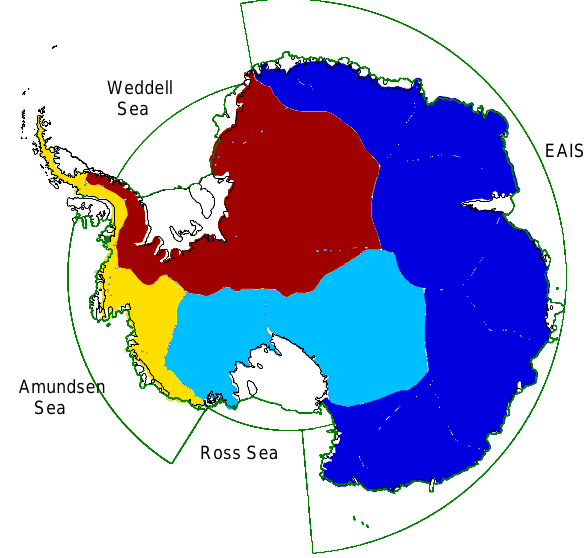
Figure 2. The four different basins for which ice-sheet response functions are derived from the SeaRISE M2 experiments. Green lines enclose the oceanic regions over which the subsurface oceanic temperatures were averaged. Vertical averaging was carried out over a 100m depth range centred at the mean depth of the ice shelves in the region taken from Le Brocq et al. (2010) as provided in Table